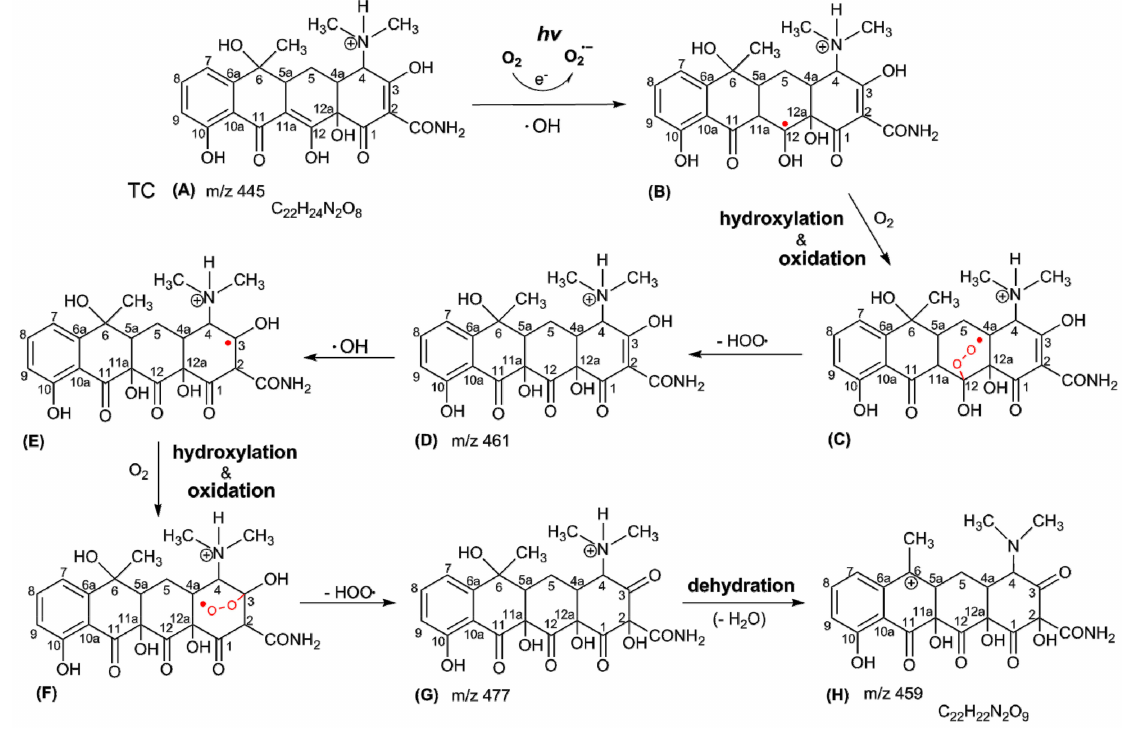
Figure 8. Proposed scheme for the TC